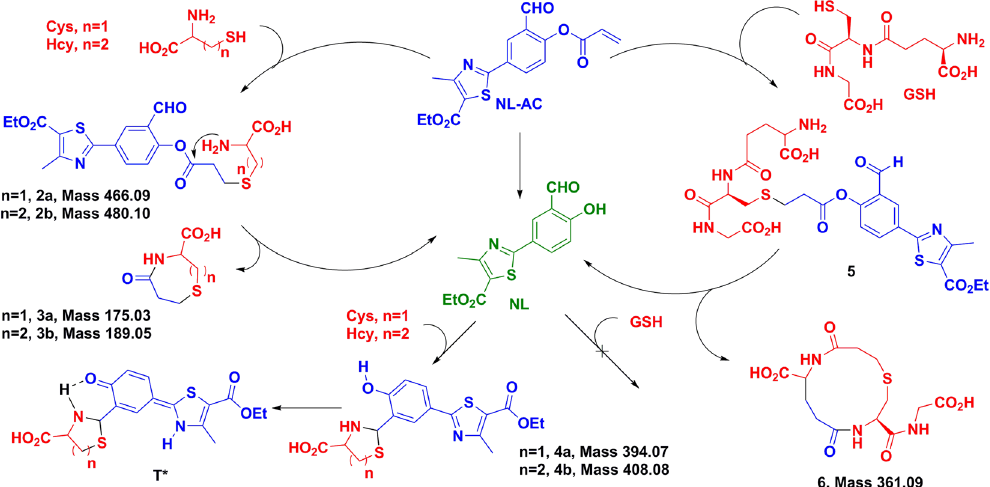
Figure 4. Proposed reaction mechanism of NL-AC with Cys, Hcy and GSH.